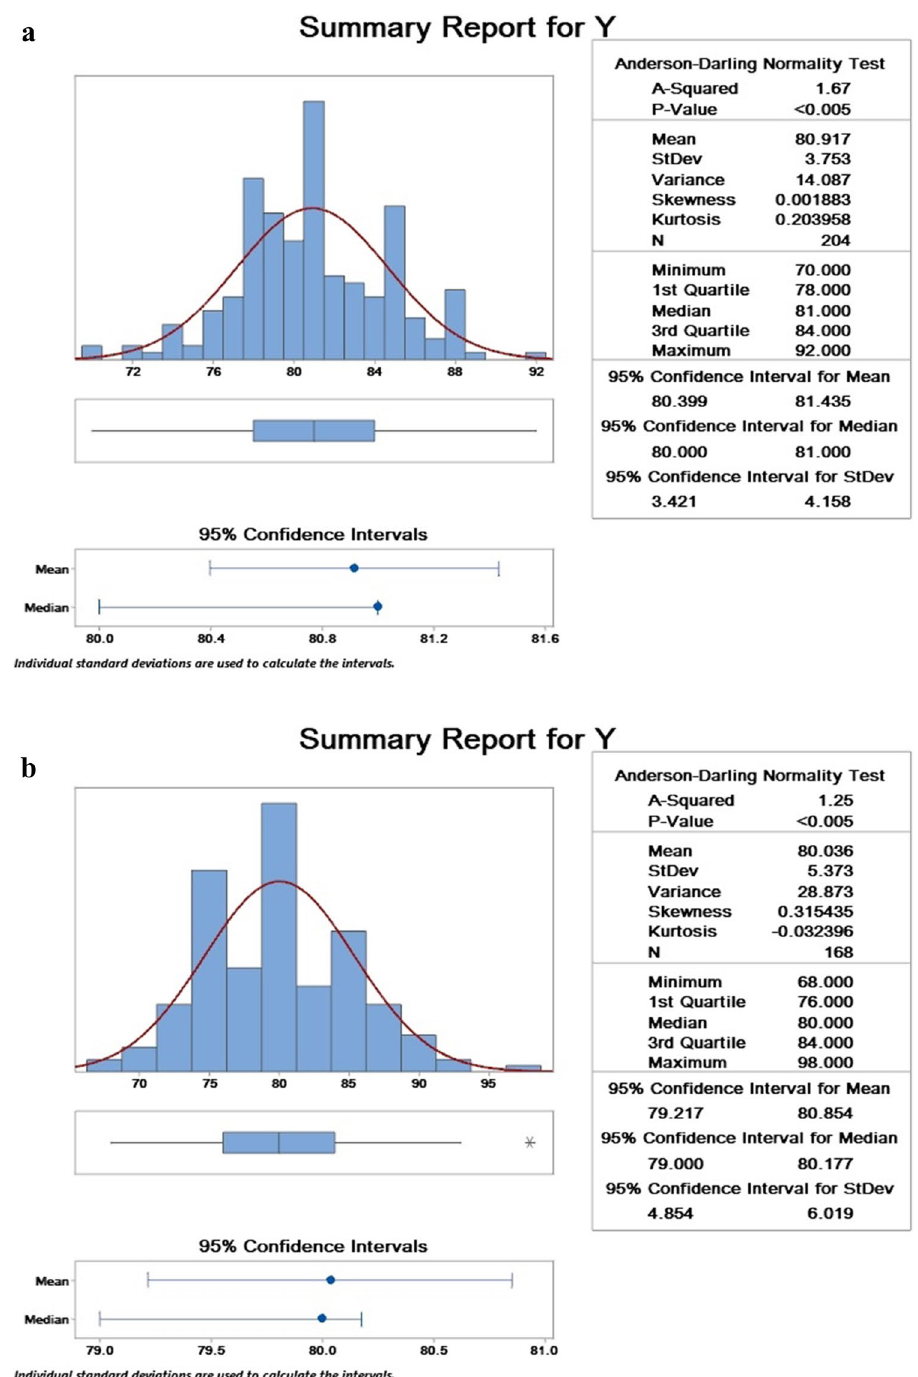
Fig. 5 a Histogram of the y — first interval. b Histogram of the y —second